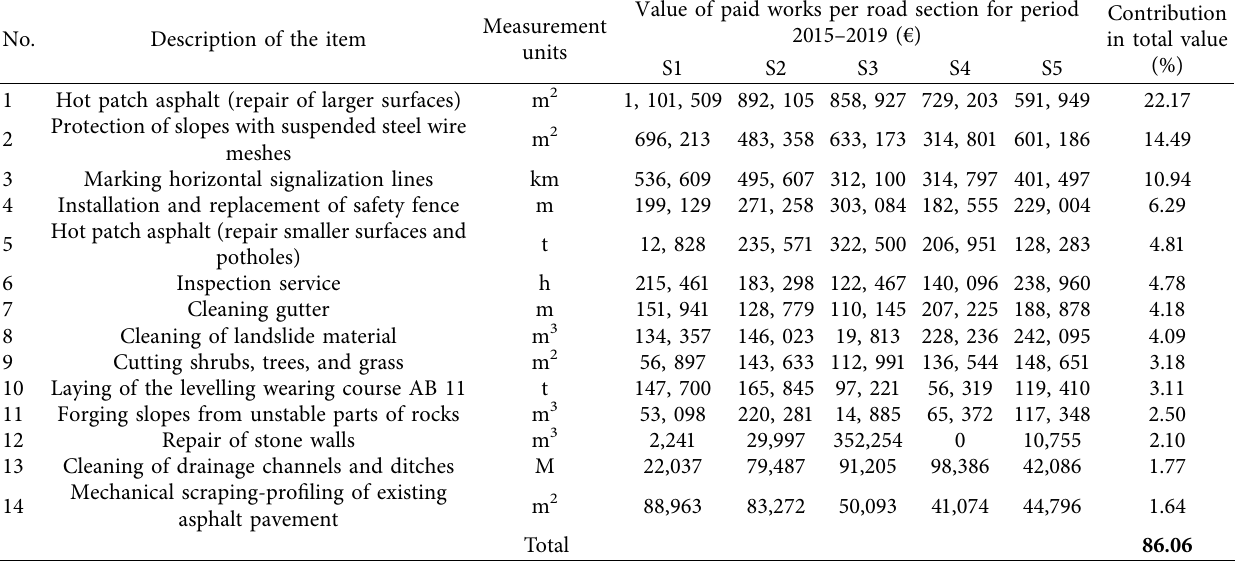
Table 3: Overview of selected works for implementation of the model.